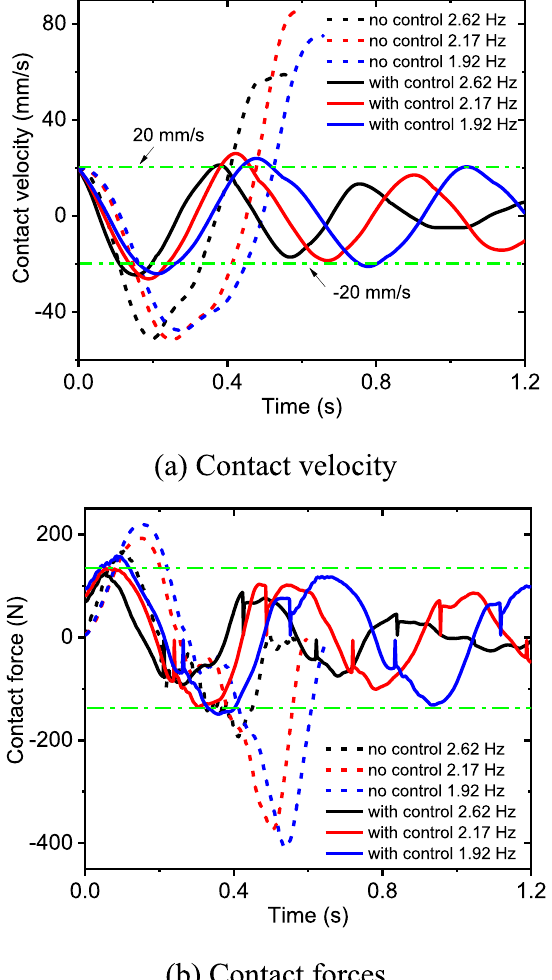
Figure 15 Contact velocities and forces in practical experiments